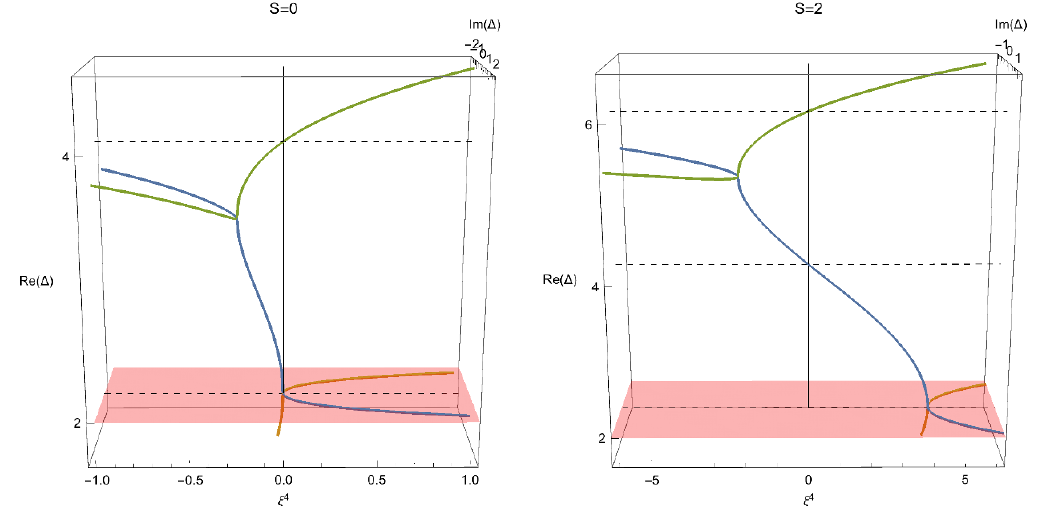
Figure 7 . Structure of the spectrum (cid:1) 0 ( (cid:24) ) for S = 0 (left) and S = 2 (right). At weak coupling (vertical solid line) it consists of two operators with bare dimension 2 + S and 4 + S . As a function of (cid:24) 2 the states can be analytically continued from one to